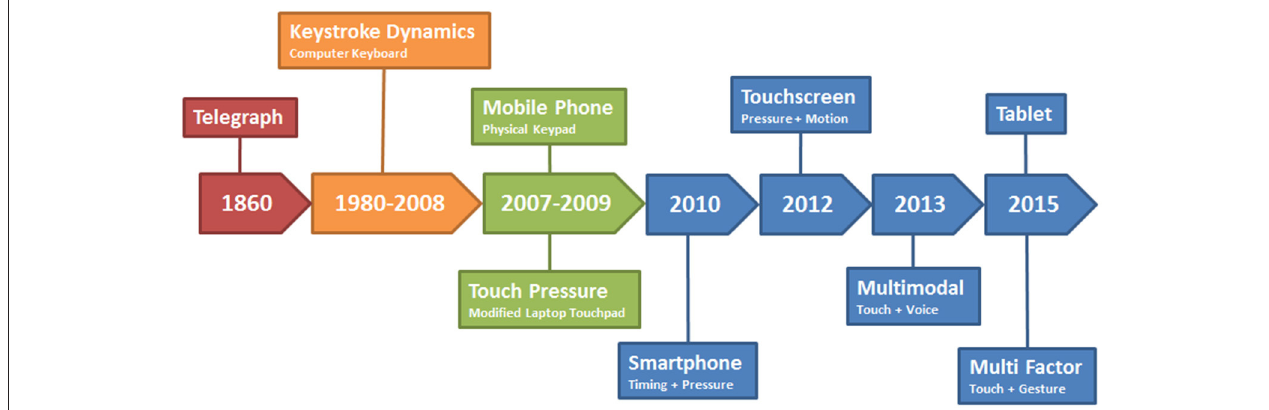
FIGURE 1 | Evolution of touchalytics research [taken from Teh et al. (2016)]. The timeline of using finger strokes for identifying users has a history (see text for historical